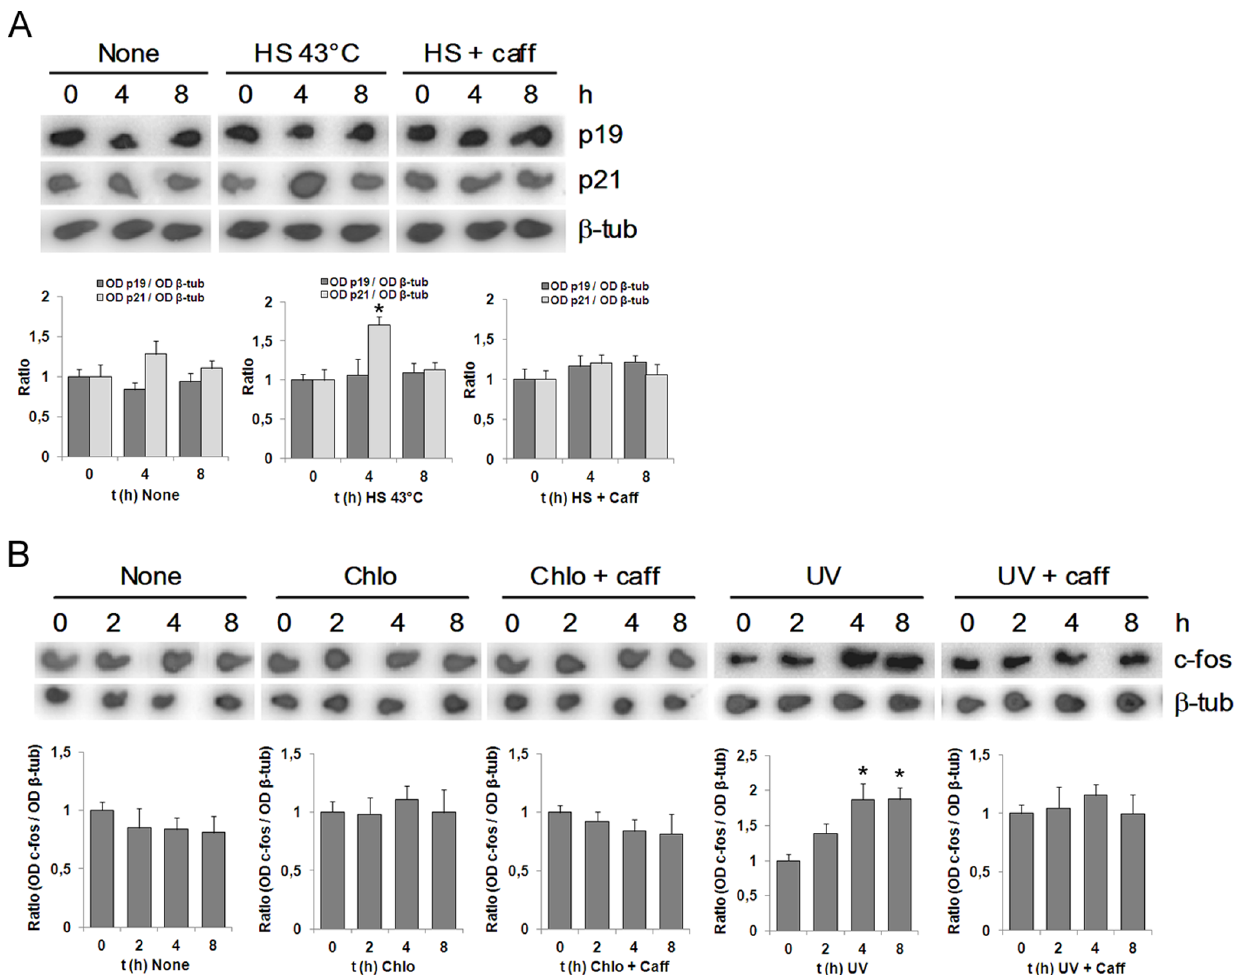
Figure 3. Chromatin relaxation-mediated induction of p19 is specific. A. HEK-293 cells, previously treated or not with 5 mM caffeine during 1 h, were incubated at 43 u C for 1 h and then cultured at 37 u C from 0 to 8 h. B. HEK-293 cells, previously treated with 5 mM caffeine for 1 h, were incubated with 100 m M chloroquine at the indicated times. In ( A ) and ( B ), cells were harvested and subjected to northern blot analysis using a 32 P- labelled probe specified at the right margin. Each figure shows a representative autoradiograph of three independent experiments with similar results. Densitometric analysis of p19, p21 and c-fos are represented in the lower panels. Bars represent the mean 6 S.D. of three experiments. Student’s t -test was used to compare samples obtained at different times with samples obtained at zero time (* p , 0.05, at least). b -tubulin ( b -tub), heat shock (HS), caffeine (caff), chloroquine (chlo).